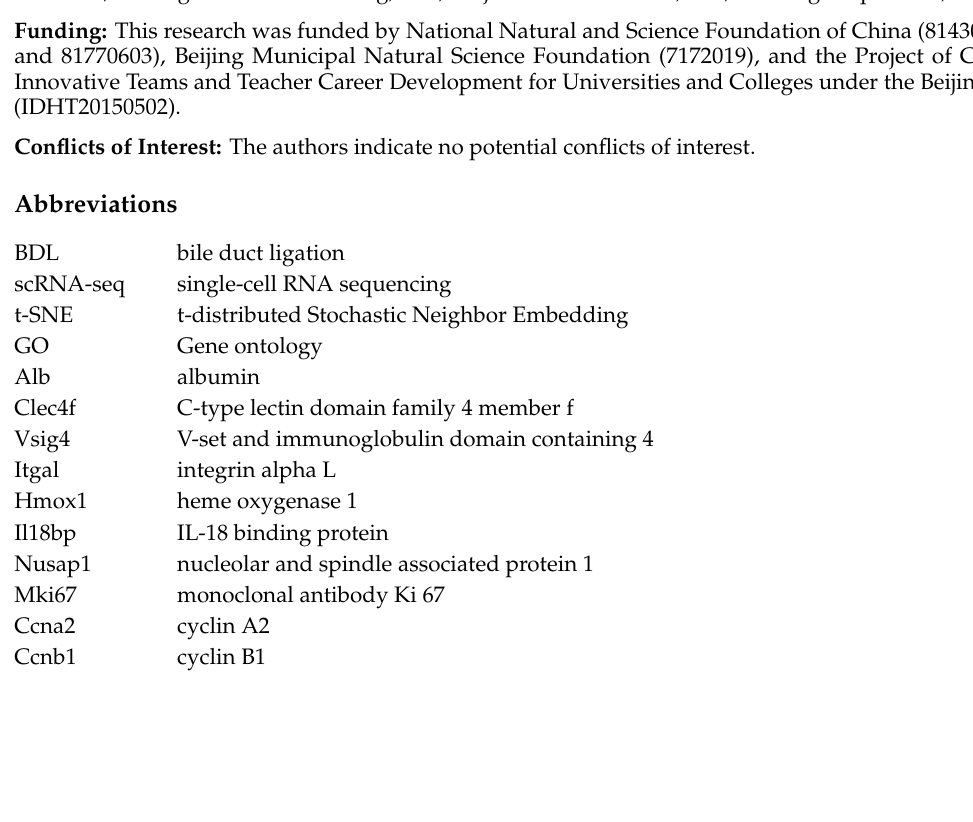
Figure S1: Quality characterization of drop-seq scRNA-seq data. Figure S2: Characterization of a hepatocyte cluster less injured isolated from cholestasis injury liver. Table S1: metrics summary. Table S2: Top10 gene among state. Table S3: High expressed genes of BDL-6. Table S4: High expressed genes of BDL-2-5. Table S5: High expressed genes of